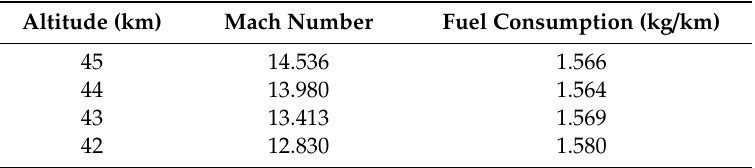
Table 2. Steady-state cruise optimization